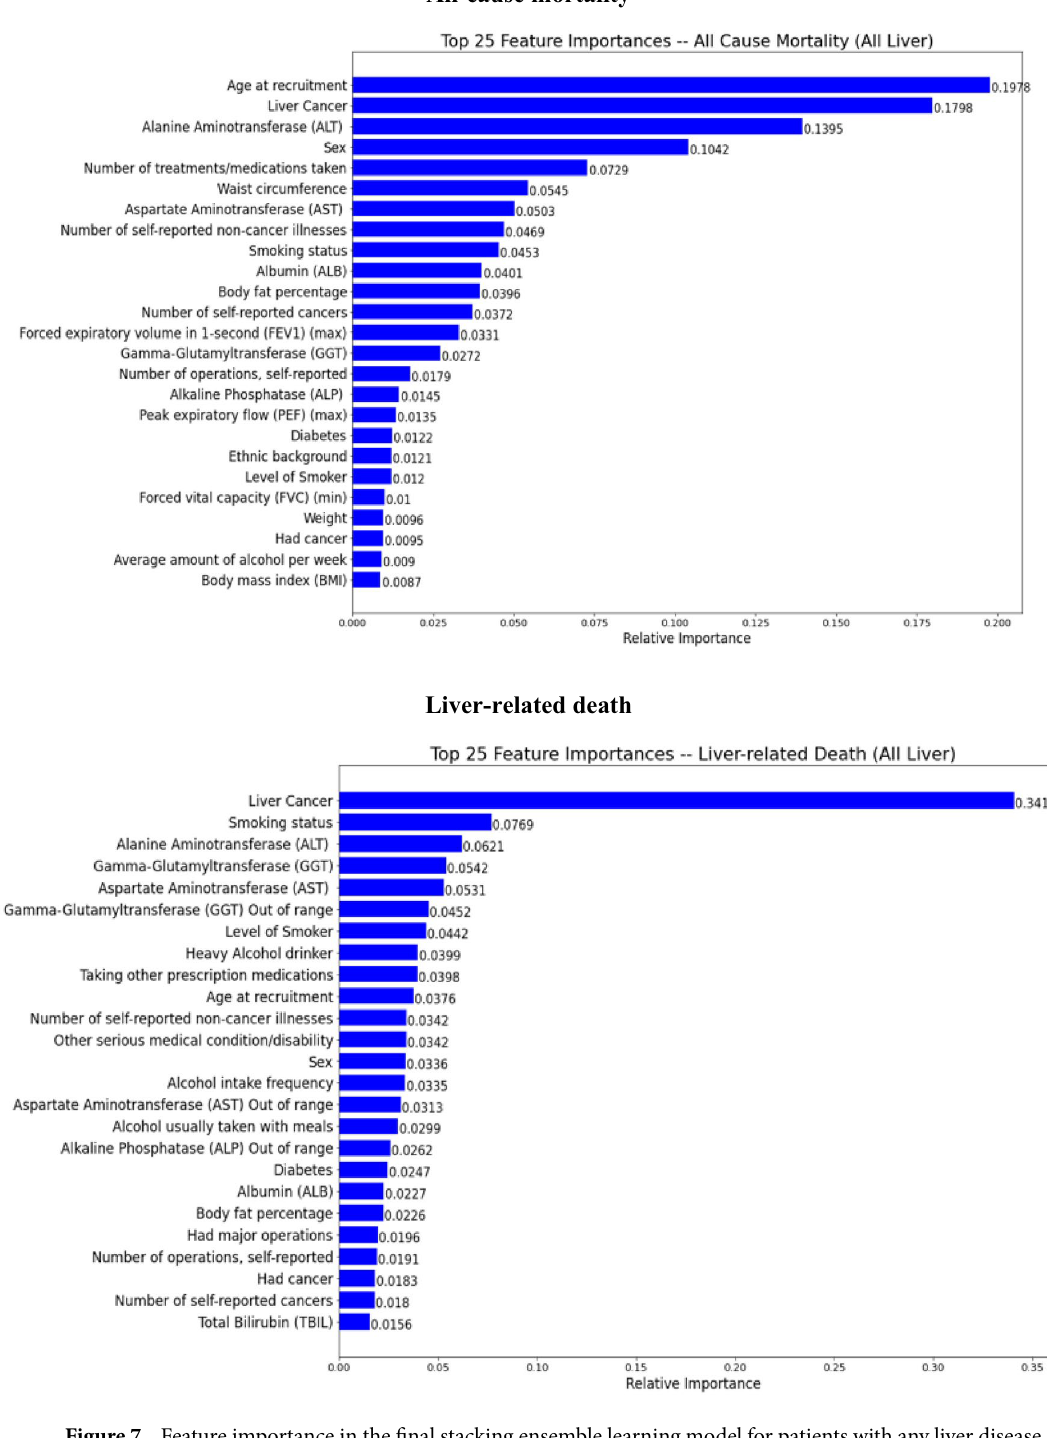
Figure 7. Feature importance in the final stacking ensemble learning model for patients with any liver disease (N = Prediction of disease progression in AATD‑LD.